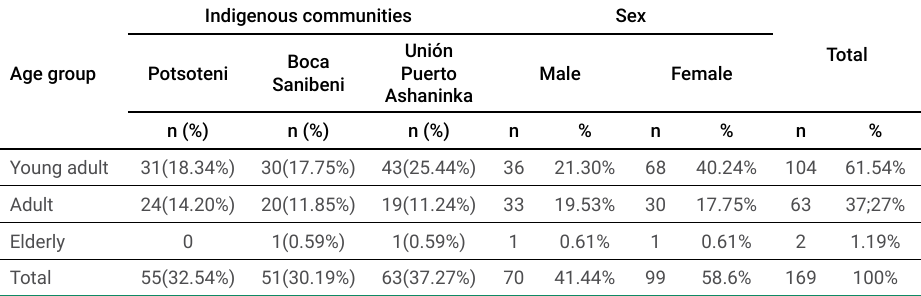
Table 1. Sample characteristics, by community, age group and sex.